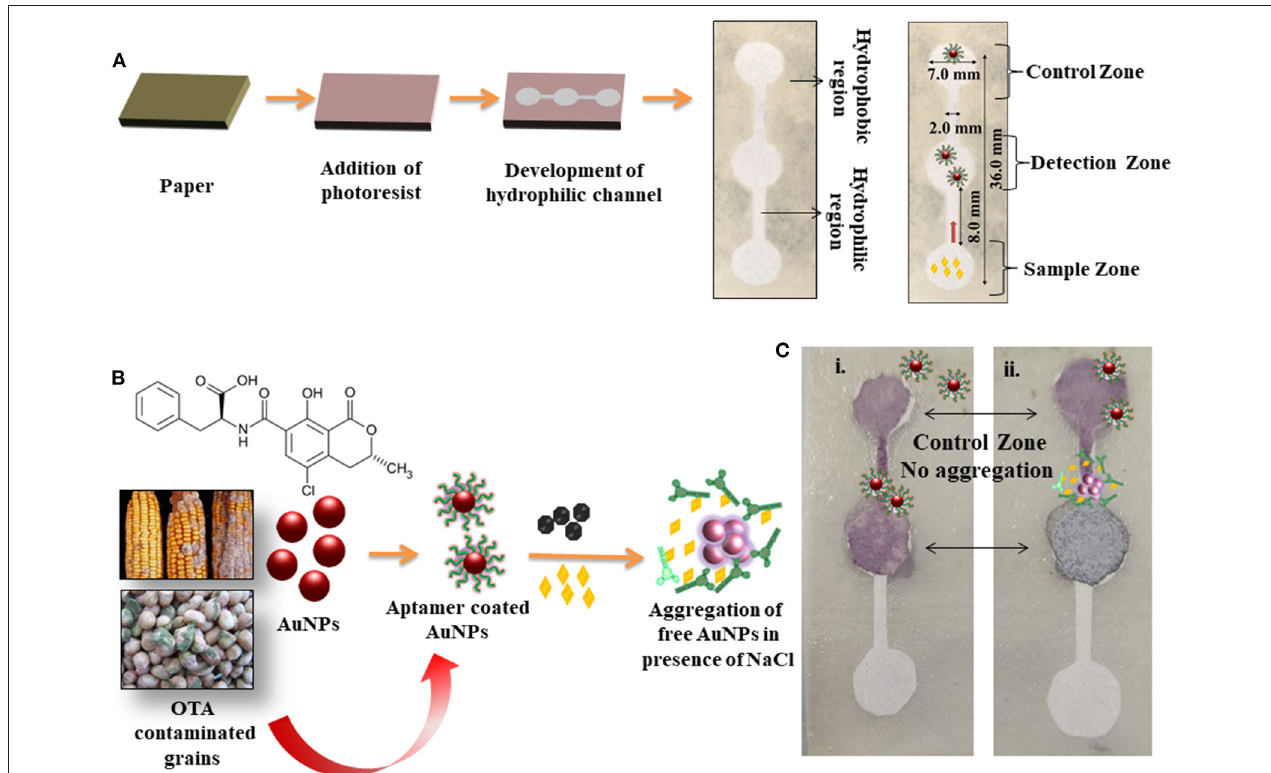
FIGURE 5 | Overview of the development of microfluidic device and detection of OTA; (A) Steps depicting the preparation of microfluidic device, generation of hydrophilic channels, and detection zones; (B) Chemical formula of OTA and scheme of colorimetric detection of OTA in the grains via aptamer switching technique; (C) Colorimetric detection of OTA in a microfluidic device in the (i) absence and (ii) presence of